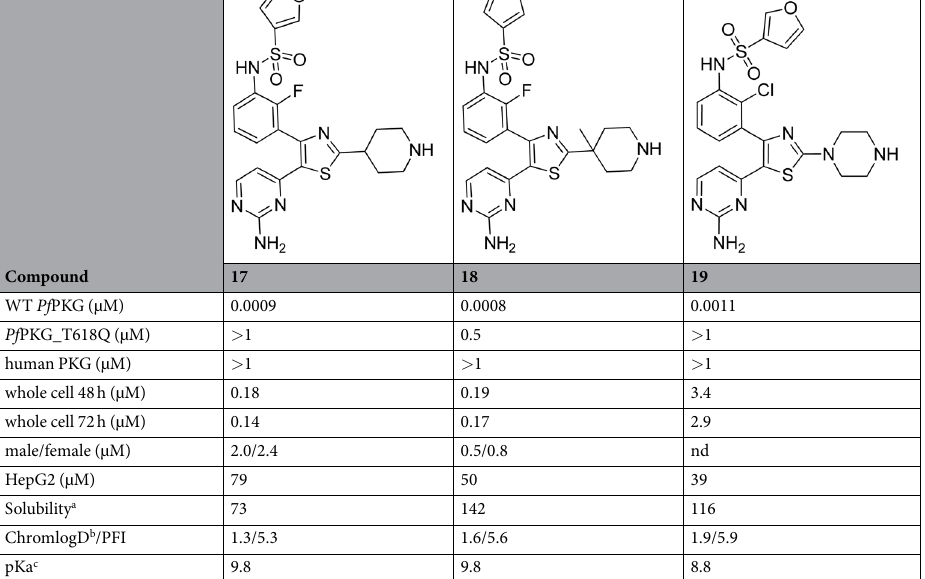
Table 2. Structure and properties of the most balanced compounds identified in this study. a Charged Aerosol